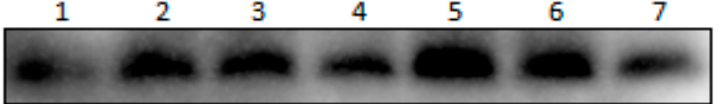
Figure 2. Analysis of gEGF expression by LL-pNZ8149-gEGF induced with different concentrations of nisin for 9 h when the optical density of 600 nm (OD 600 ) of the bacterial cultures reached 0.4. Lanes 1–7: the 20 μ L/well of supernatant from the induced cultures of the LL-pNZ8149-gEGF with nisin of 0, 1, 2.5, 5, 10, 20, and 40 ng/mL, respectively.